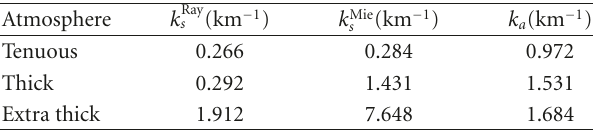
Table 1: Atmosphere model